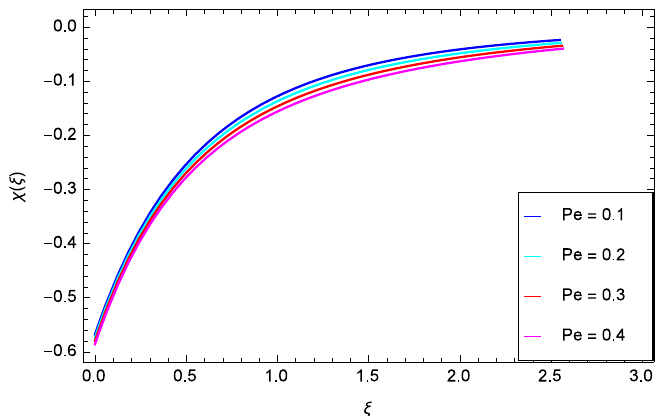
Figure 20. Impact of the Peclet number Pe on motile microorganism χ ( ζ )